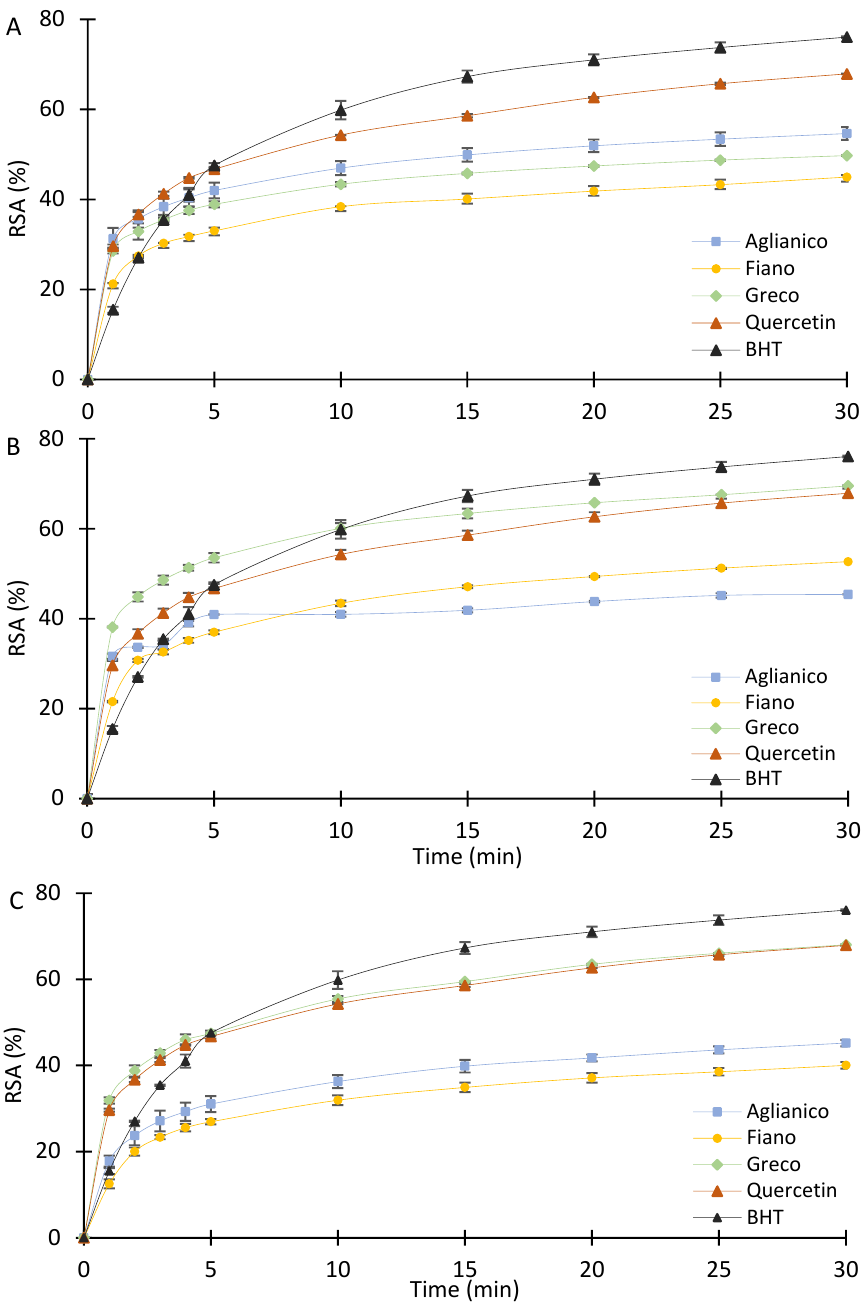
Figure 3. Free Radical Scavenging Activity of “Aglianico”, “Fiano”, and “Greco” grape cane extracts at pH 1.00 ( A ), 7.00 ( B ), 13.00 ( C ), and antioxidant reference compounds. DPPH assay was performed with 5 µg GAE of extracts or pure reference compounds as described in Section 3.4.1. All determinations were performed in triplicate and results were expressed as mean ± SD.